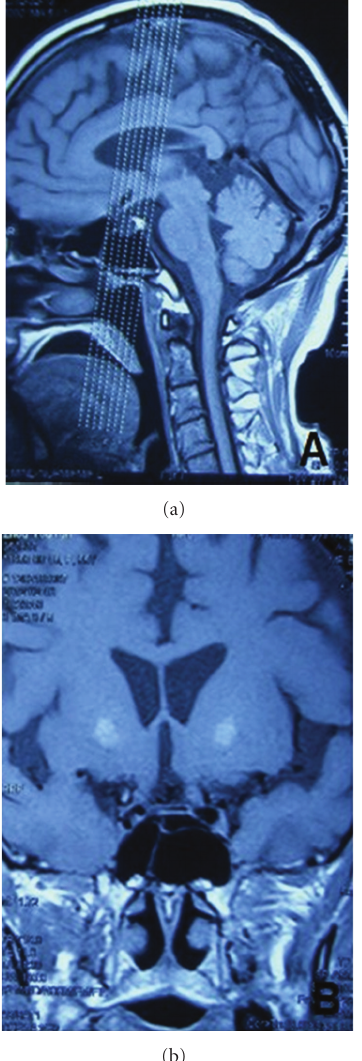
Figure 2: The sagittal (a) and coronary (b) noncontrast T1 weighted magnetic imaging (MRI) of the brain shows a diminutive pituitary and an empty sella